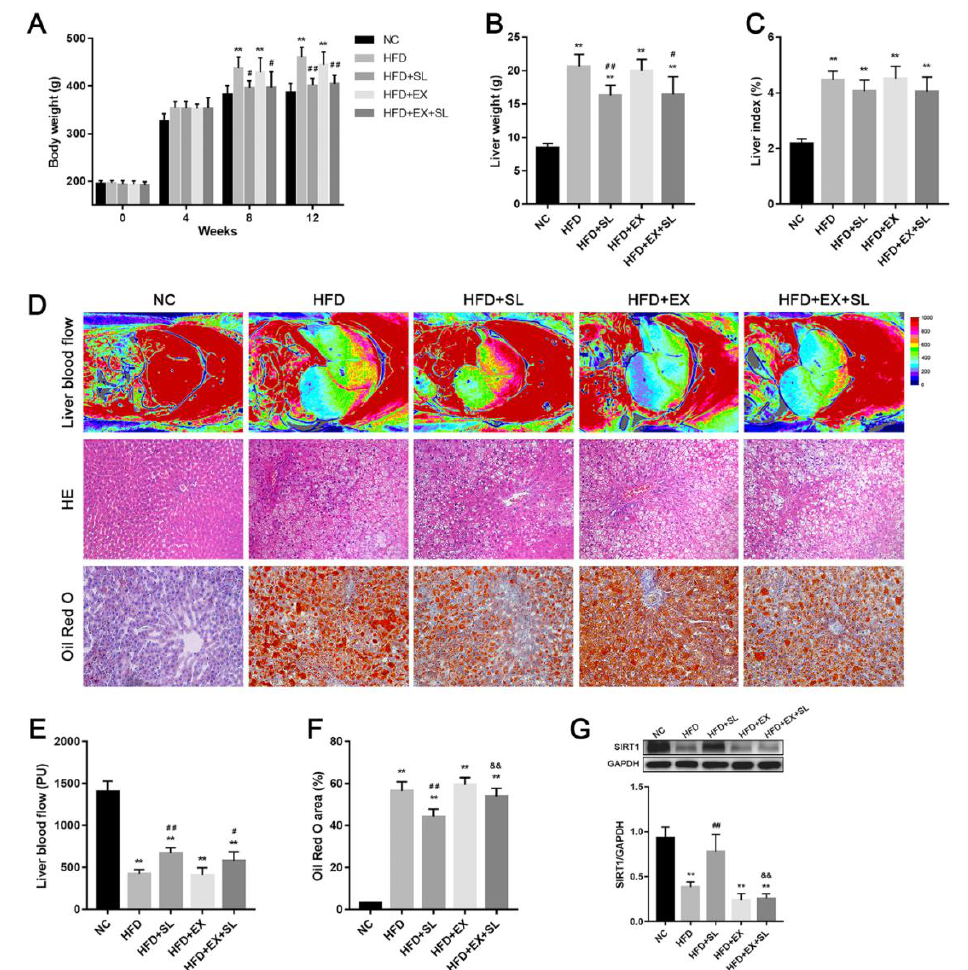
Figure 1. Body characteristics and liver histology in the five groups. ( A ) Body weight. ( B ) Liver weight. ( C ) Liver index. ( D ) Representative images of liver blood flow (upper panel), HE staining (middle panel, × 200 magnification) and Oil Red O staining (bottom panel, × 200 magnification) of the liver. ( E ) Quantification of liver blood flow. ( F ) Quantification of Oil Red O-positive area. ( G ) Western blot analysis of SIRT1 expression in the liver. ** p < 0.01, compared with NC group; # p < 0.05, ## p < 0.01, compared with HFD group; && p < 0.01, compared with HFD + SL